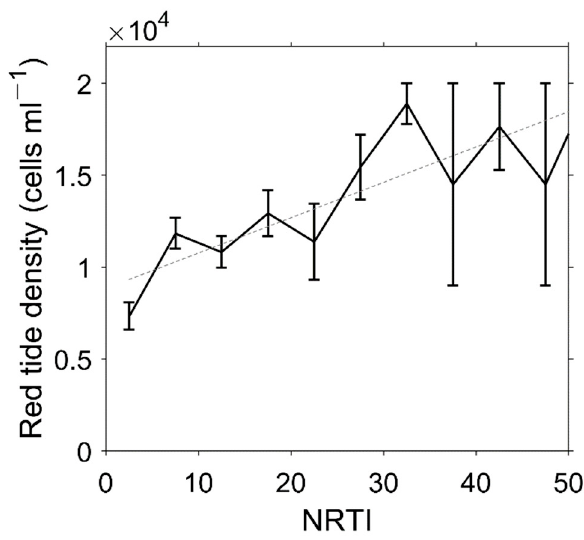
Figure 10. Variations of in situ red tide density as a function of NRTI at the in situ red tide occurring region (04 UTC, 13 August 2013). Solid line represents the mean and standard error of red tide density within each NRTI bin. Dashed line indicates linear regression between NRTI and red tide density (eq. 9).